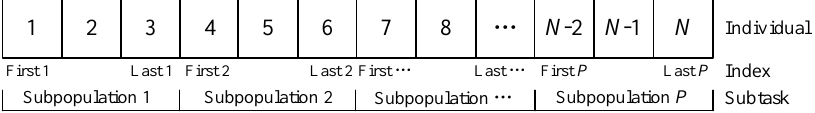
Figure 2. Map of the population decomposition in parallel multi-objective genetic algorithm (PMOGA).